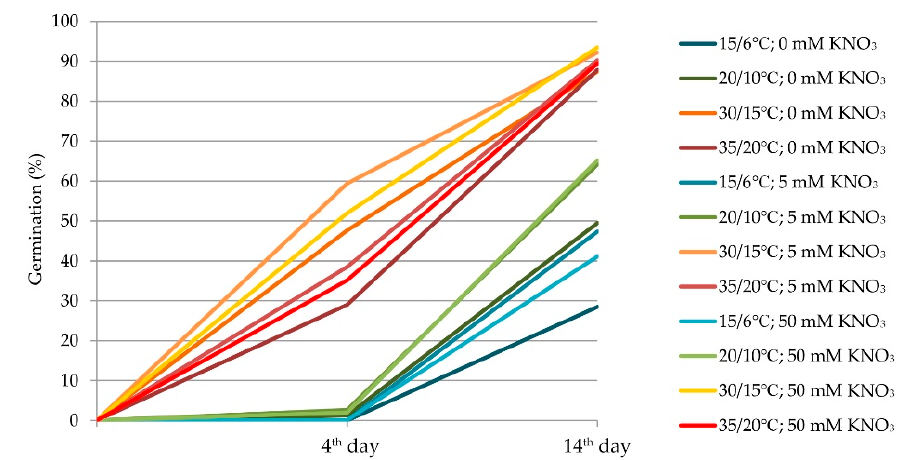
Figure 1. Dynamics of seed germination (%) under light conditions at the different temperature regimes and KNO 3 concentration.